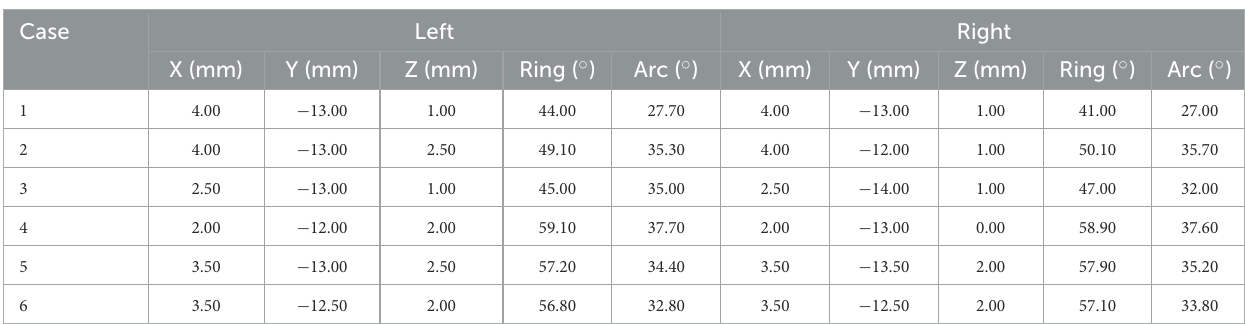
TABLE 2 Target coordinates of the bilateral LHb in each